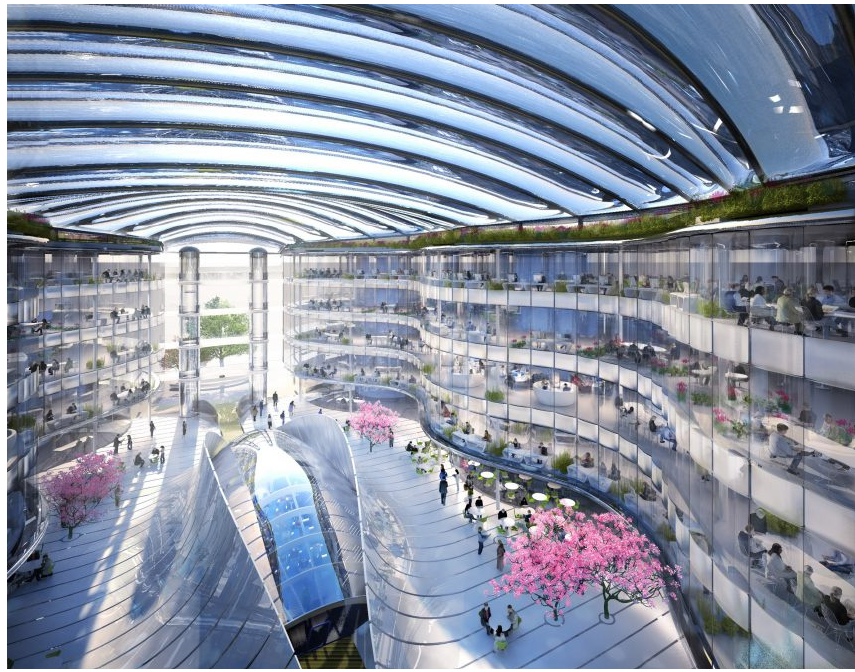
Figure 4. Exploration Architecture’s Biomimetic Office mimics the spookfish’s eye structure (https://www.dezeen.com/2020/10/22/michael-pawlyn-exploration-architecture-dassault-systemes- video/, accessed on 22 October 2010). The angled plates of the mirror in the spookfish eye create a curved shape that allows the maximum amount of reflected light and the sharpest possible image (Figure 6a,b). The fish is predicted to change the mirror’s position to center on objects from varied distances.